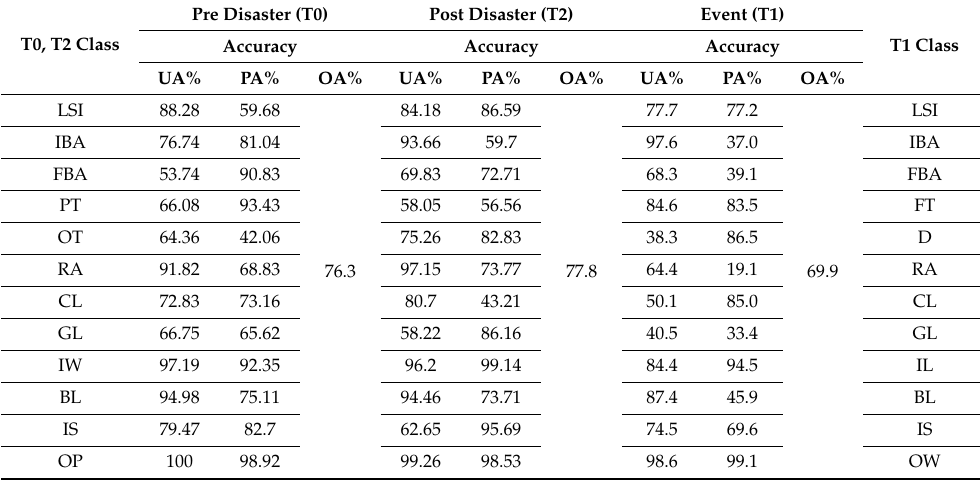
Table 7. Comparison of land use classification accuracies, user and producer accuracies, and corresponding errors are computed across the study area. LSI: Large scale industry; IBA: Informal built-up area; FBA: formal built-up area; PT: Palm tree; OT: Other tree; RA: Recreational area; CL: Crop land; GL: Grass land; IL: Inundated land; BL: Bare land; IS: Impervious surface; OP: Open water: